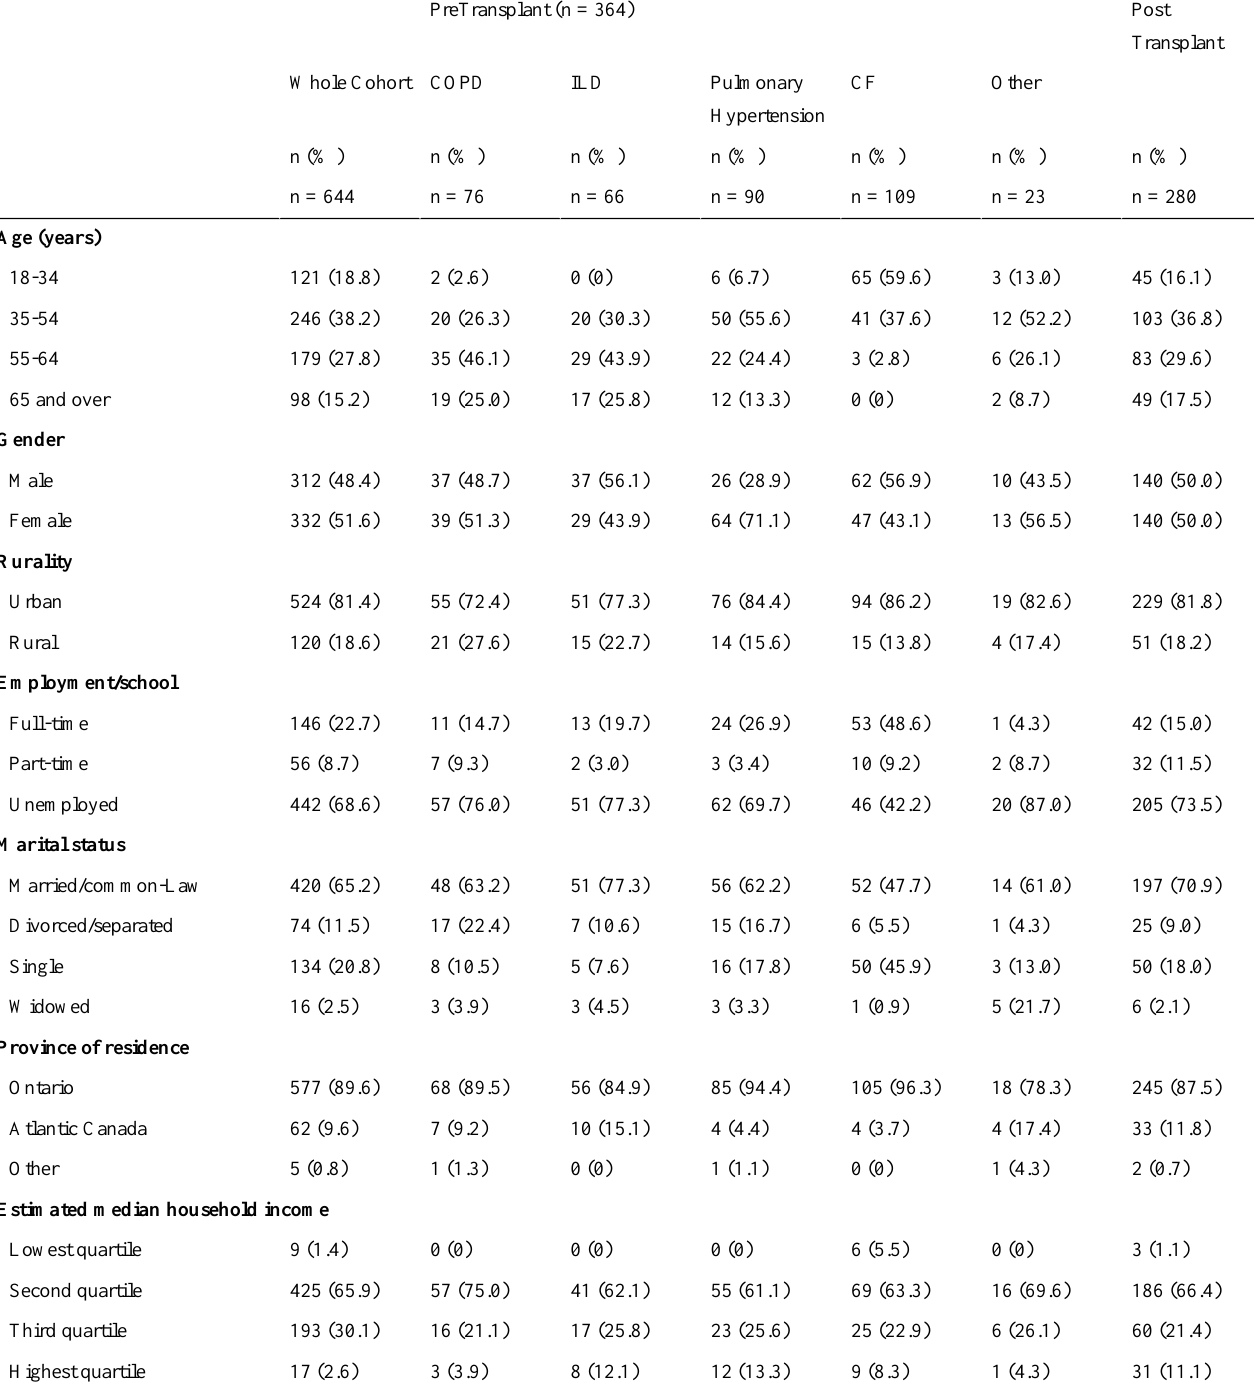
Post TransplantPreTransplant (n = 364)